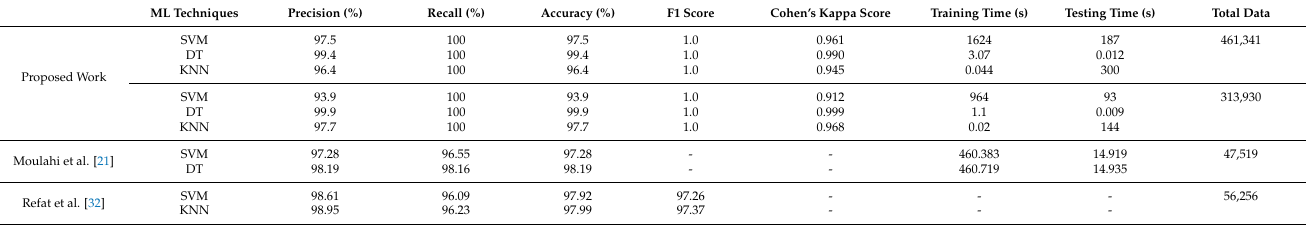
Table 11. A comparison of the proposed work with existing techniques for intrusion detection.